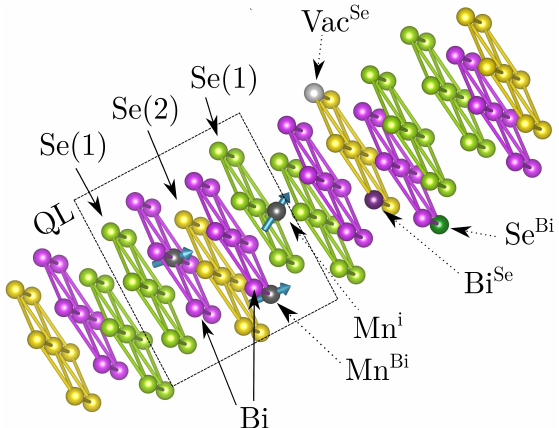
Figure 1. Layered crystal structure of Bi 2 Se 3 . Se and Bi layers gathered into QLs are depicted. Examples of (non)-magnetic defects are shown: (Mn Bi ) substitutional Mn atoms, (Mn i ) interstitial Mn atoms, (Bi Se ) resp. (Se Bi ) Bi and Se antisites, (Vac Se ) Se